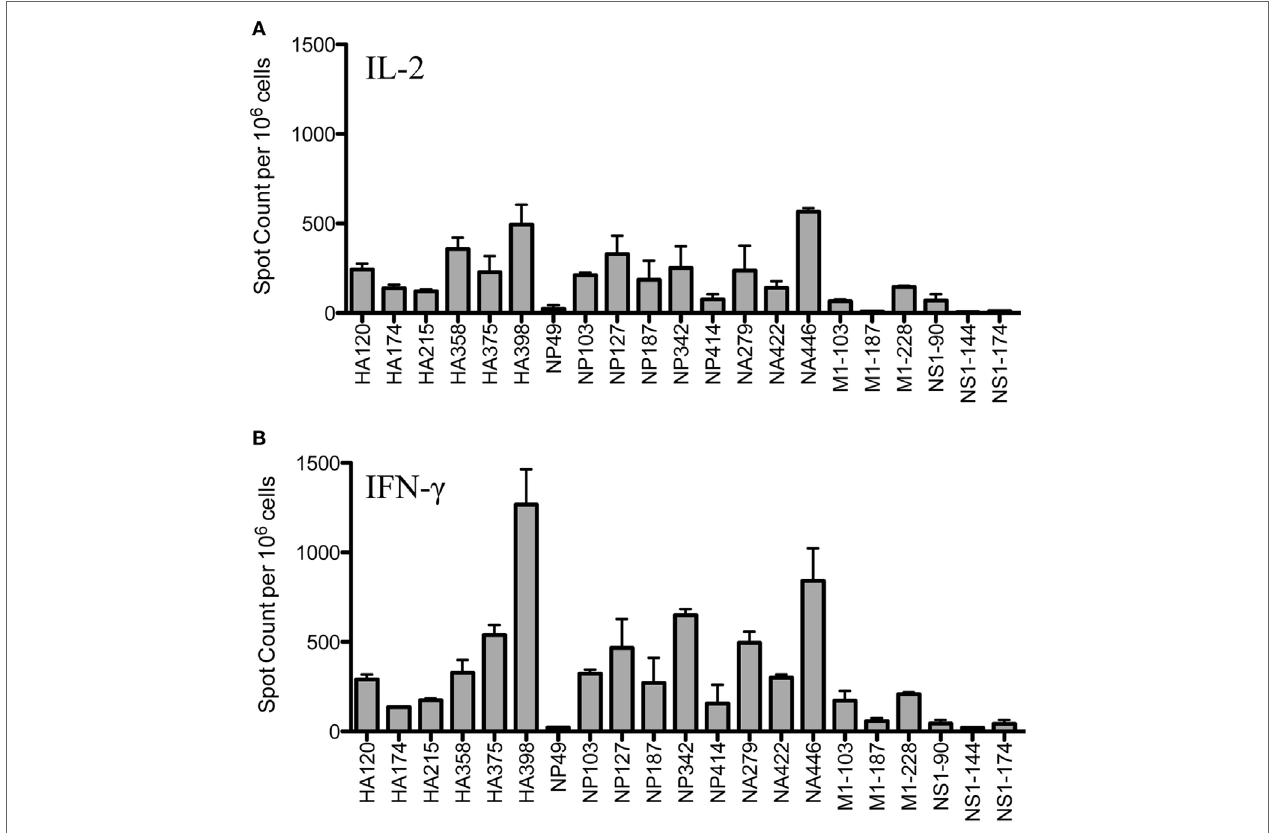
FigUre 1 | Infection elicits CD4 T cells of broad epitope diversity. Female A/J mice (aged 2–6 months) were infected intranasally with 50,000 EID 50 of A/New Caledonia/20/99 H1N1 virus, and the number of peptide-specific cytokine producing cells from the spleen were quantified. IL-2 cytokine EliSpots (a) are quantified in the top panel and IFN- γ producing cells (b) are shown in the bottom panel. Results are represented as cytokine-producing spots per million CD4 T cells and represent the average of two independent experiments with the range